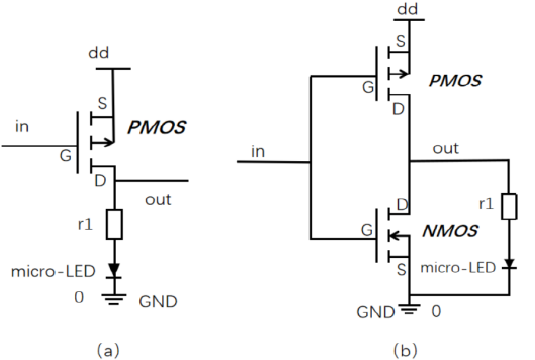
Figure 16. ( a ) PMOS series current limiting resistor driving Micro-LED; ( b ) CMOS inverter connected in series with current limiting resistor to drive Micro-LED.